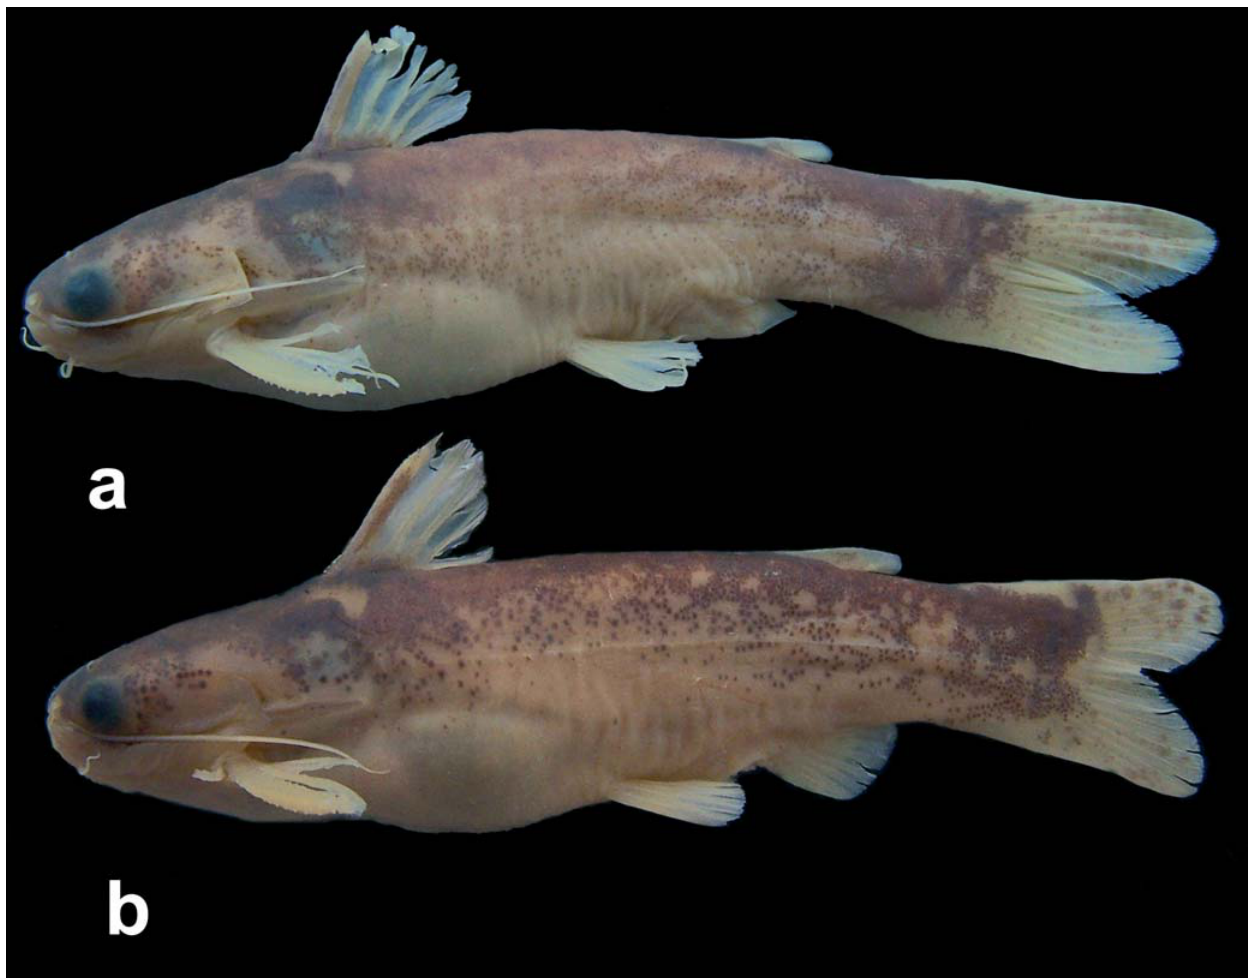
Fig. 10. Tatia boemia , (a) MZUSP 47921, paratype, male, 64.5 mm SL. (b) MZUSP 47921, paratype, female, 52.4 mm SL, rio Pelotas, Rio Grande do Sul State,